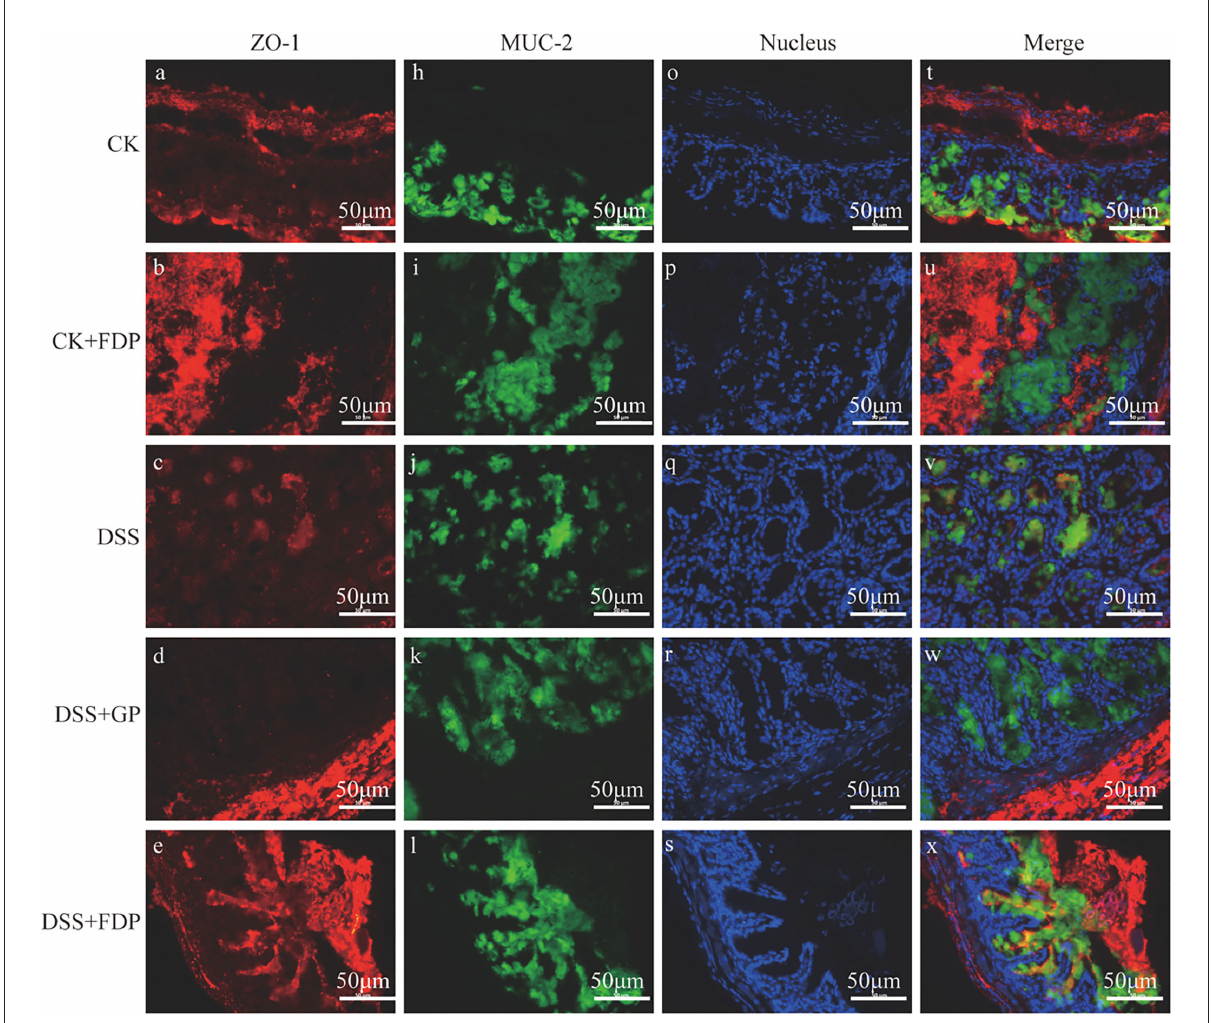
FIGURE1 Effects of fermented egg-milk peptides (FEMPs) treatment on the expression of ZO-1 (red) and MUC-2 (green) in colitis mice. The pictures were observed by a fluorescence microscope of 400 × . CK, control check. CK + FDP, control check and drink FEMPs freely. DSS + FDW, DSS and drink water freely. DSS + GP, DSS and gavage FEMPs. DSS + FDP, DSS and drink FEMPs freely. The different labels a-x represented for the different